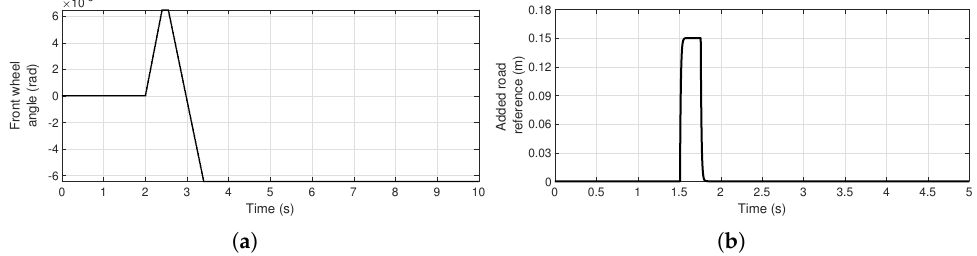
Figure 2. Test signals used for validation. ( a ) A fish-hook maneuver applied on the front wheel [35]. ( b ) An exogenous vertical road reference pulse to simulate a speed bump. The risk indexes are validated by comparison with those obtained from CarSim by direct calculation from its definitions (Equations (11), (16) and (18)); this software provides the longitudinal, lateral and vertical forces on the wheels. Since CarSim does not provide the angular accelerations for roll and pitch, these are calculated in Simulink; regardless of IMU and proper signal conditioning.